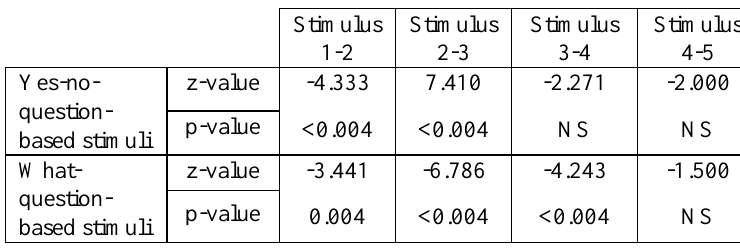
Table IV. z- and p-values of four Wilcoxon matched pairs signed rank tests comparing the identification rate between adjacent stimuli for yes-no-question- and what-question-based